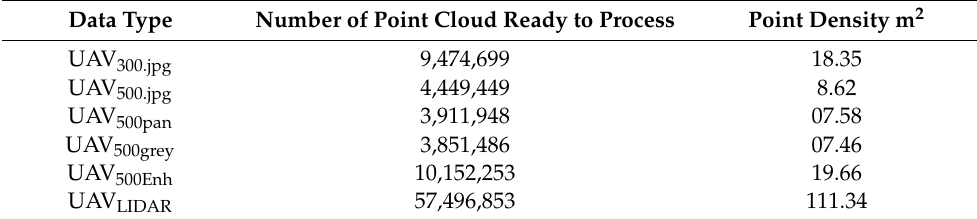
Table 3. Point Cloud comparison